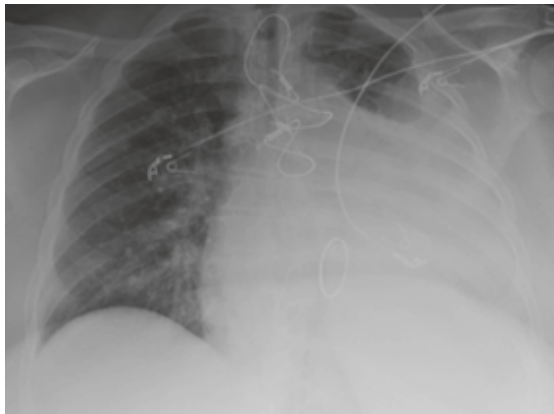
Figure 2: Pleural fluid sample. Of note, the whole amount of the drained fluid (1 liter) had the same color and consistency and did not clear by the end of drainage.